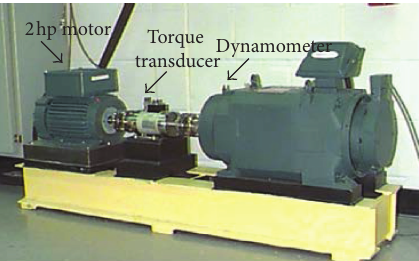
Figure 5: Bearing test system.